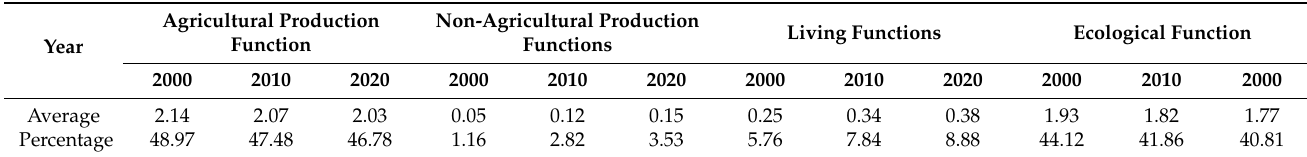
Table 1. Descriptive statistics and contribution rates of multifunctional land use in the Yangtze River Delta region,